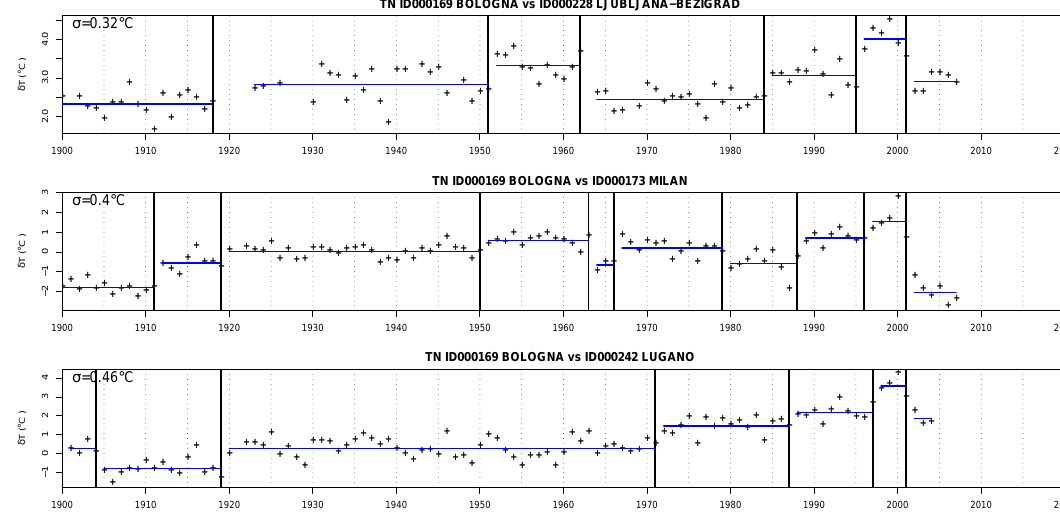
Fig. 3. Discontinuities detected on annual difference from Bologna versus neighbouring ECA&D minimum temperature series. quoting Capra,